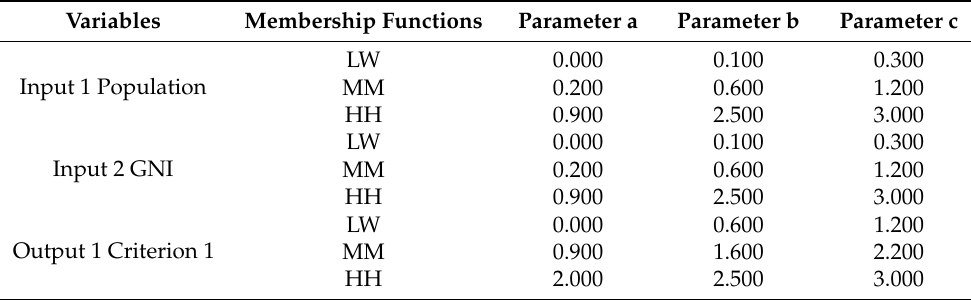
Table 10. First Type-1 FIS: Input-Output